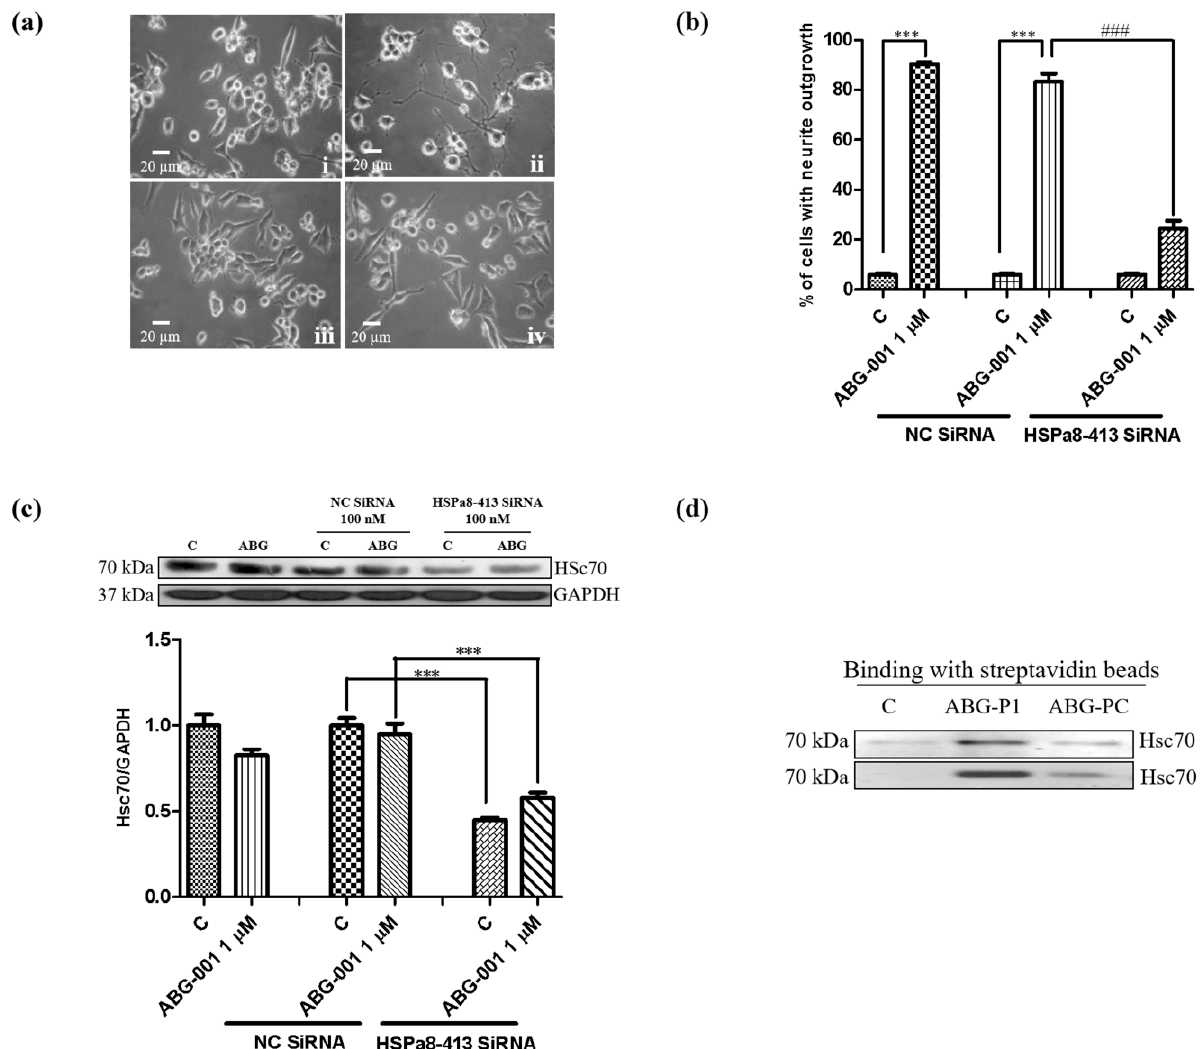
Figure 5. Target prediction of ABG-001 in PC12 cells by using siRNA assay and further confirmation by pull down assay. ( a ) Microphotographs of PC12 cells after treatment with siRNA and ABG-001: (i) negative control siRNA, control (0.5% DMSO); (ii) negative control siRNA, ABG-001 (1 µ M); (iii) Hsc70 siRNA, control (0.5% DMSO); (iv) Hsc70 siRNA, ABG-001 (1 µ M). Scale bar, 20 µ m. ( b ) Percentage of cells with neurite outgrowth after treatment with siRNA and ABG-001. ( c ) Western blot analysis for Hsc70 after transfection with negative siRNA or Hsc70 siRNA and treatment with ABG-001. ( d ) The Hsc70 protein was detected by pull-down assay. ***, ### indicate significant differences at p < 0.001 compared with the corresponding groups.